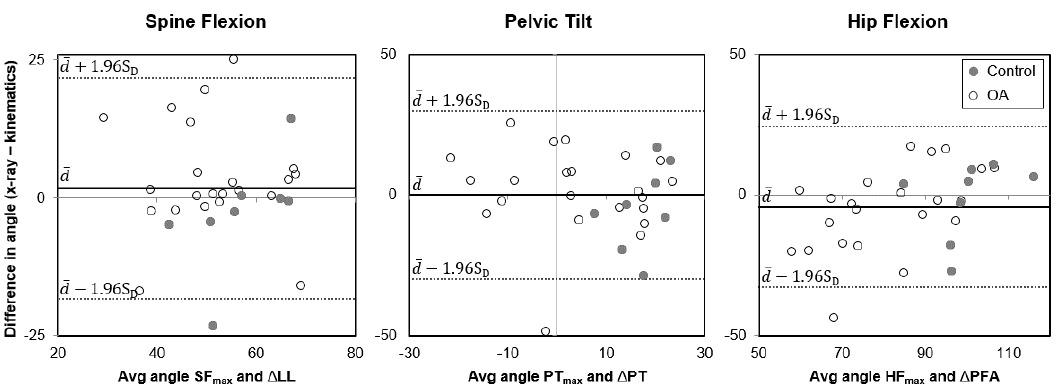
Figure 4. Bland–Altman scatter plots for the joint angle assessments in the radiographic measurements (i.e., ∆ LL, ∆ PT, and ∆ PFA) versus the motion capture system (i.e., SFmax, PTmax, and HFmax) for the three joints of interest: spine, pelvis, and hip. The solid line is the zero-error line ( d ); the dotted lines are the limits of agreements ( d ± 1.96SD). Grey markers = control participants; white markers = OA patients.